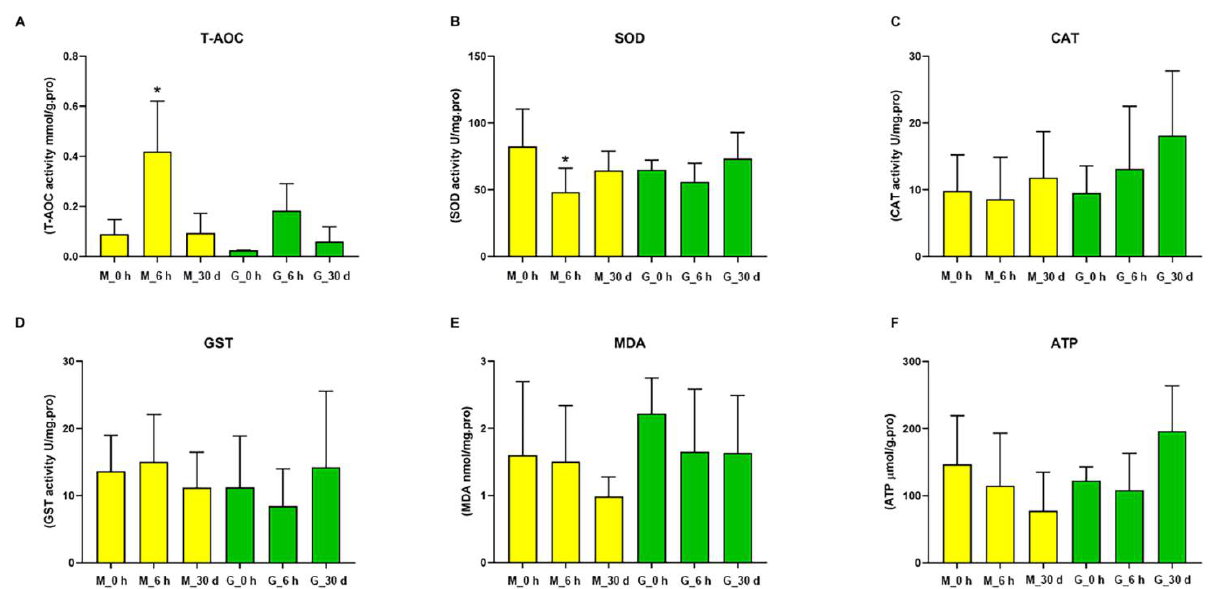
Figure 6. Antioxidant activity and the content of MDA and ATP in mantle and gill tissues of C. farreri under heat stress for 6 h and 30 d. ( A ) total antioxidant capacity (T-AOC); ( B ) superoxide dismutase (SOD); ( C ) catalase (CAT); ( D ) glutathione S-transferases (GST); ( E ) malondialdehyde (MDA); ( F ) ATP. * denotes significant differences from the control group.